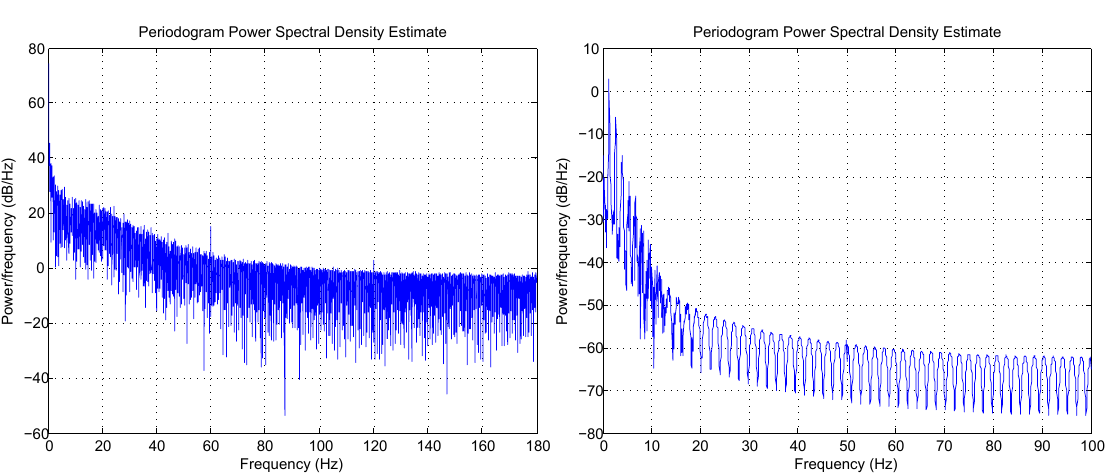
Figure 3. Periodogram for ECG signal ( left ) and PPG signal ( right ) shown in Figure 1.